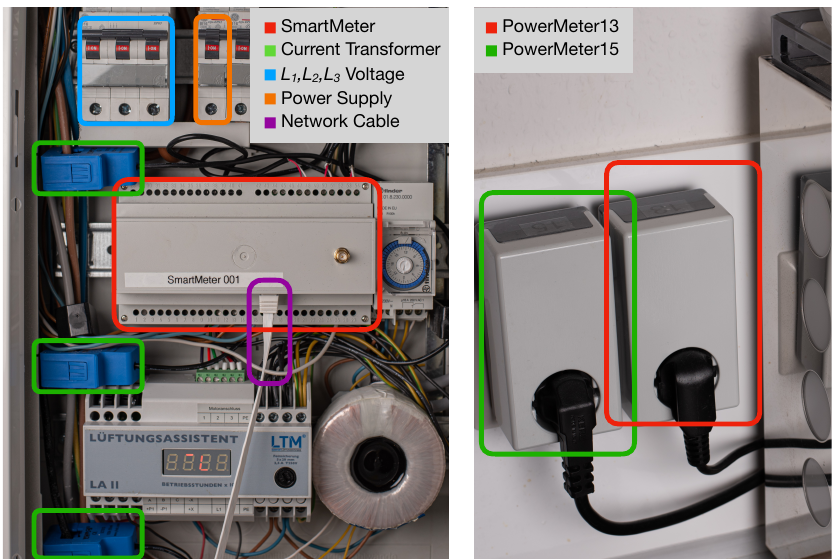
Figure 6. ( Left ) SmartMeter installed in the apartment’s fuse box. ( Right ) PowerMeters with ID 13 and 15 connected to the coffee grinder and the espresso